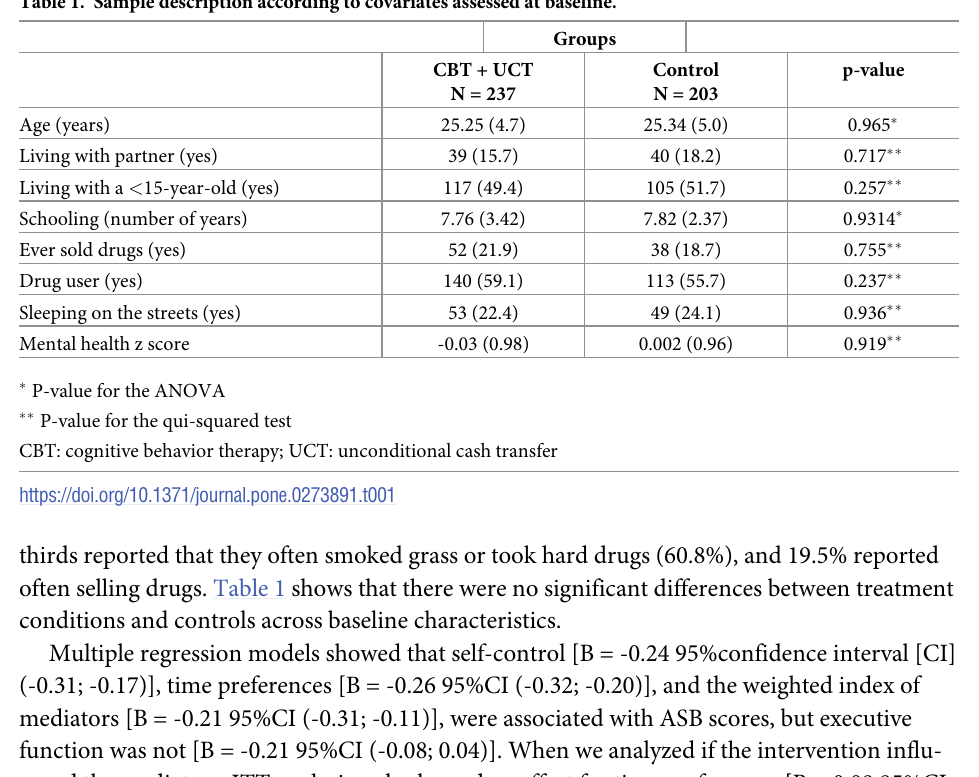
Table 1. Sample description according to covariates assessed at baseline.